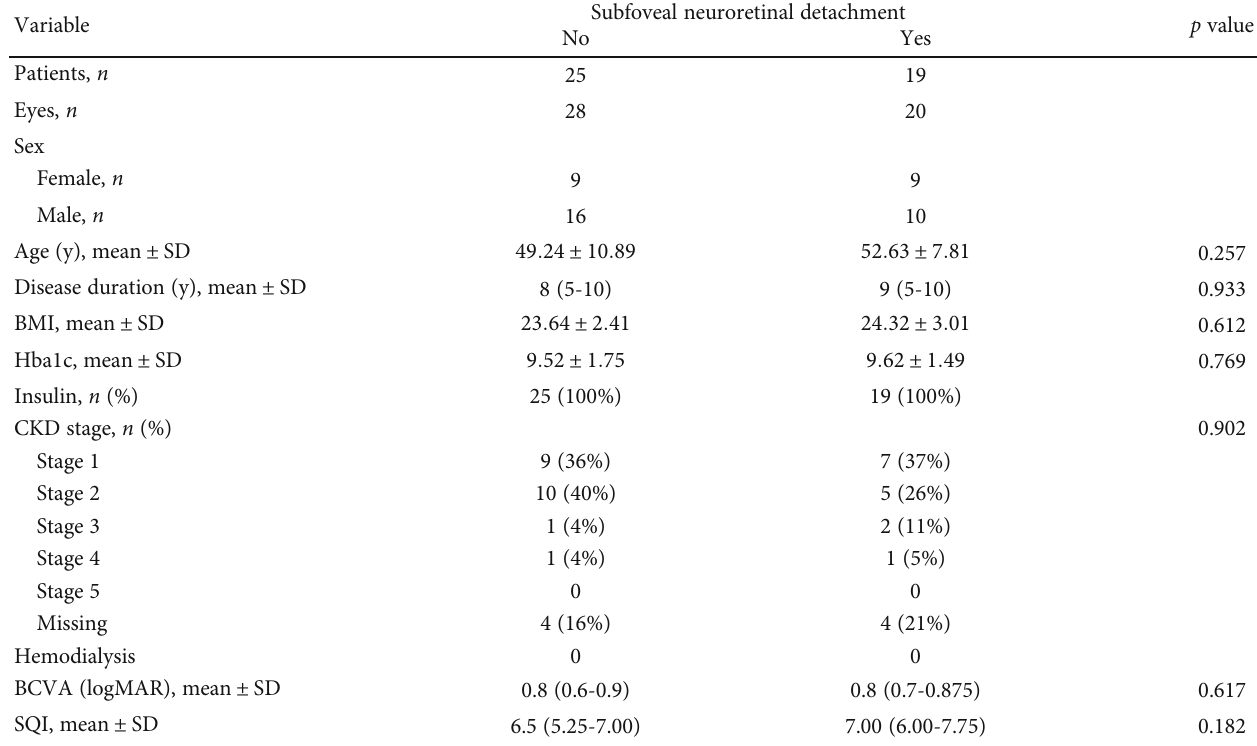
Table 1: Demographics and clinical characteristics of the study participants.